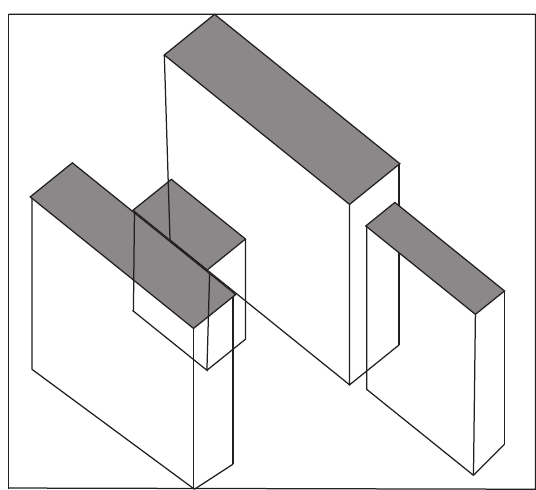
Figure 6: Housing scenario generation results.